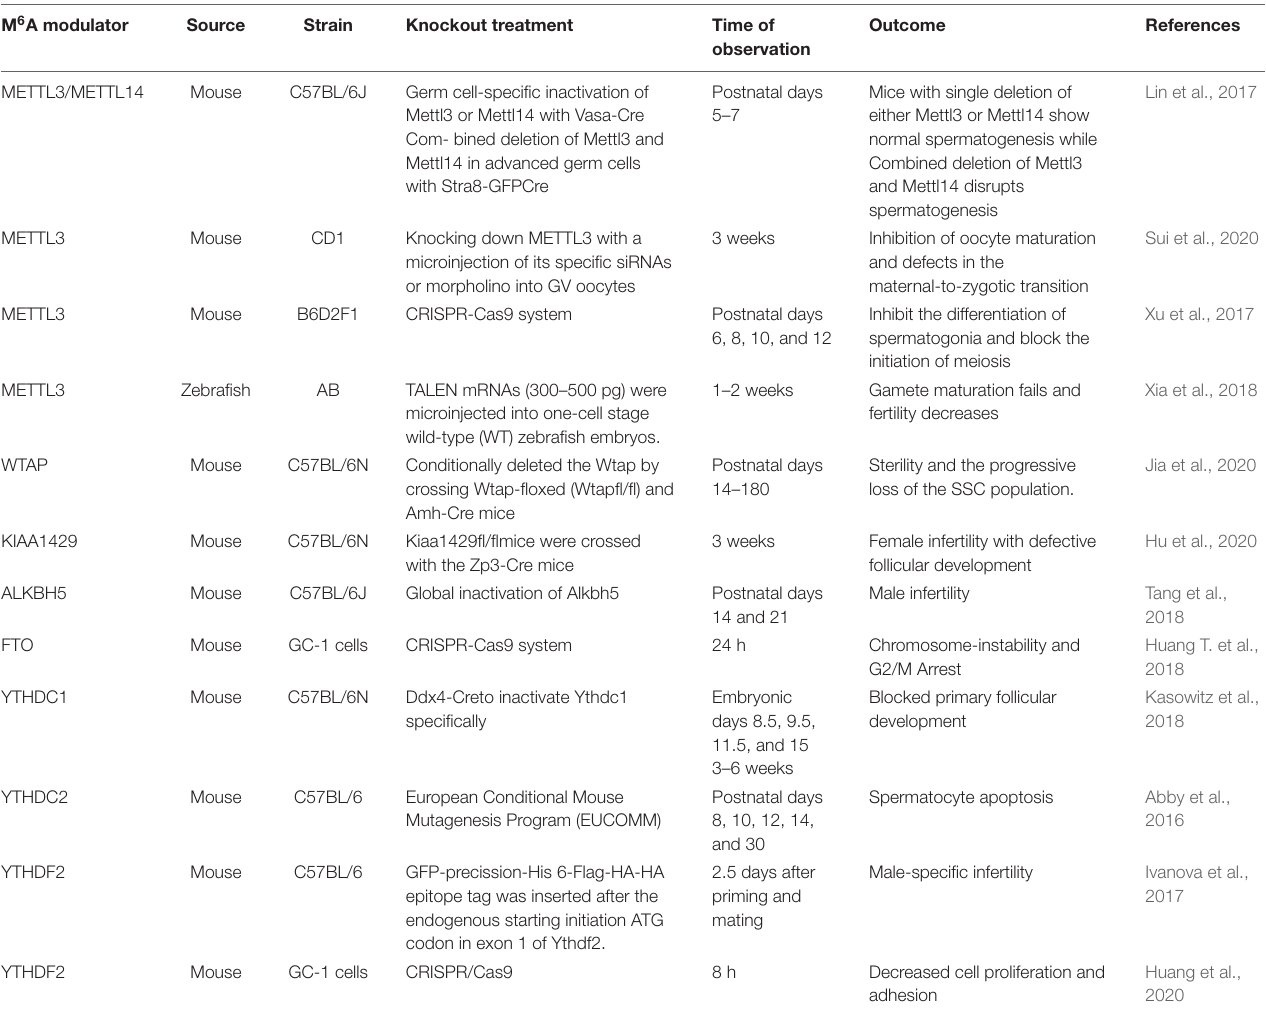
TABLE 1 | m 6 A writer, eraser, binding protein, and